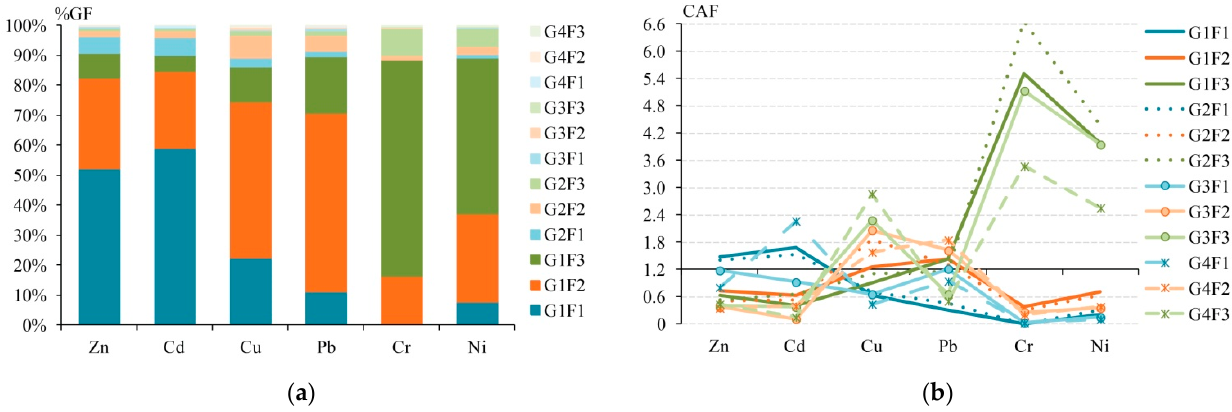
Figure 4. The fractionation distribution of HMs ( a ) and levels of chemical affinity factor (CAF) for HMs ( b ) for GF-fractions of road dust from Benowa suburbs, Gold Coast, South East Queensland, Australia—calculated from the data of A. Jayarathne et al. [100].